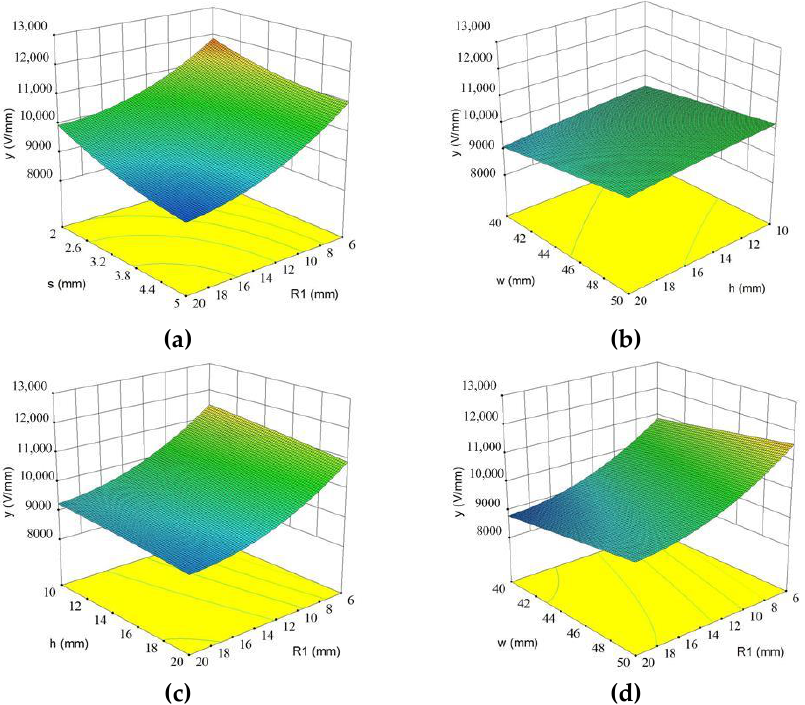
Figure 7. 3-D plotof the interaction between two variables: ( a ) R 1 s , ( b ) hw , ( c ) R 1 h , and ( d ) R 1 w .